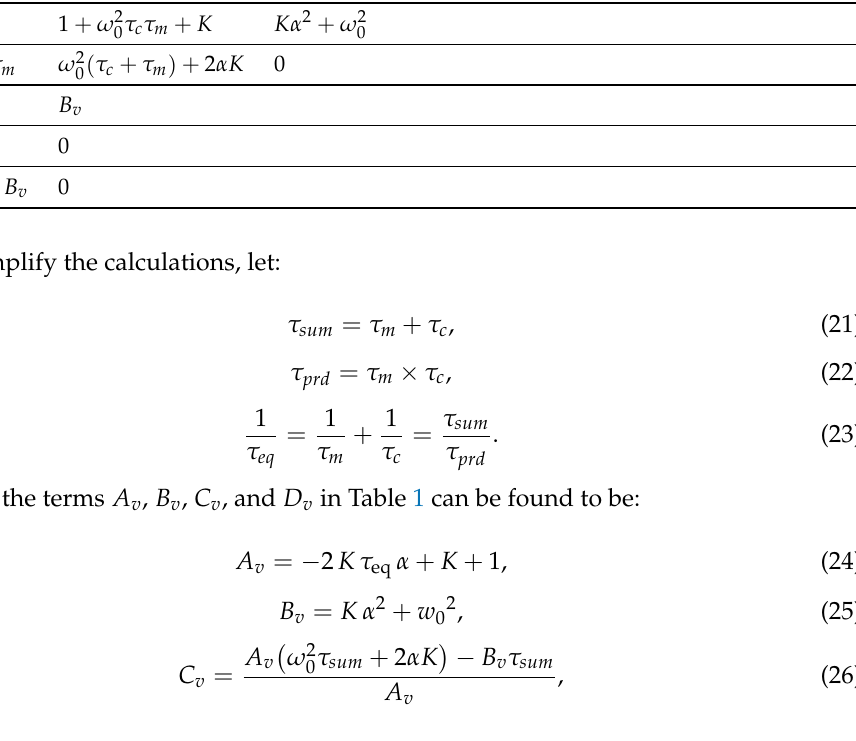
Table 1. Routh table for the velocity control